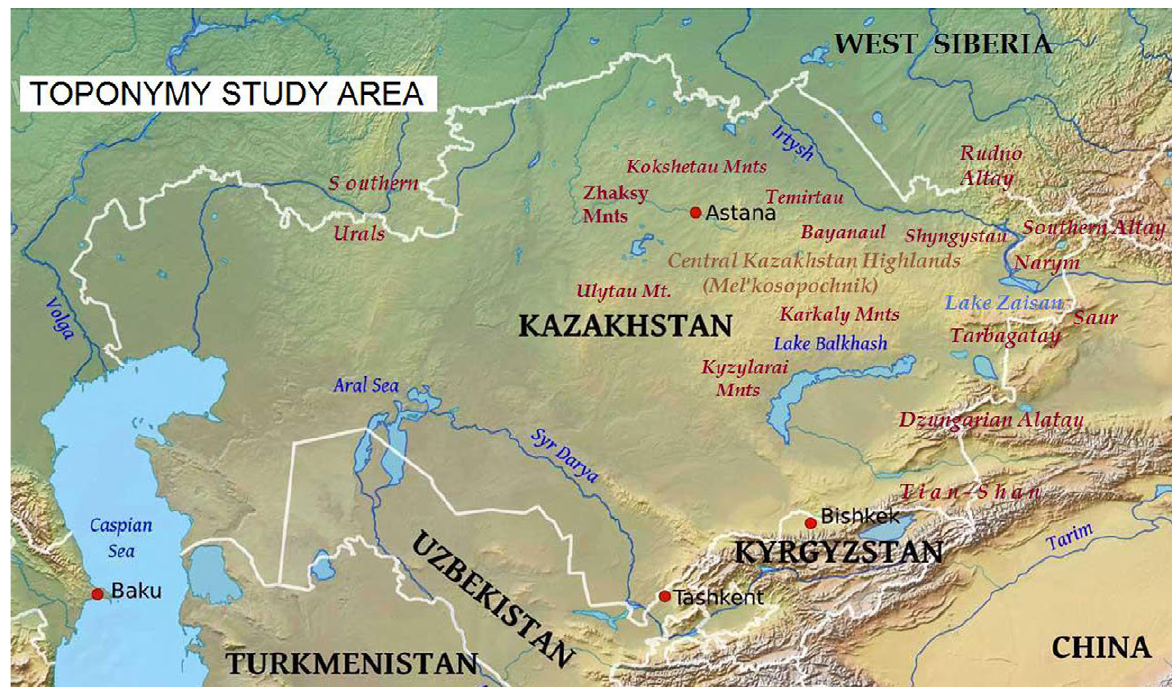
Fig. 1. Geographic location of the study area with the oronyms and hydronyms of northern and eastern Kazakhstan (the territory of Sary-Arka) discussed in the